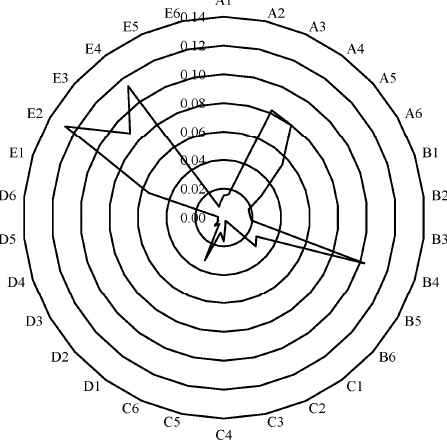
Figure 2. Index weight distribution of level 2 sub target layer. Table 2. The related variables of driving factors of social network